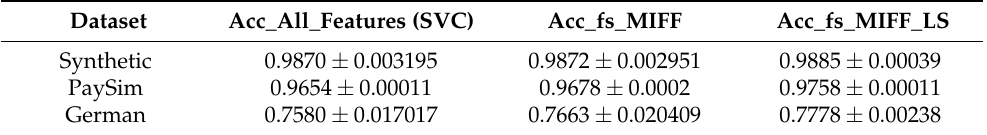
Table 4. Statistical results for accuracy for different datasets. Mean and standard deviation of the results are shown for 100 resample analysis. In rows are the results for the different datasets. In columns are the analyses for the different set of features included in the process. Columns from left to right correspond to the inclusion of all available features, IVI with MIFF filter, and IVI with MIFF filter in the latent space (using